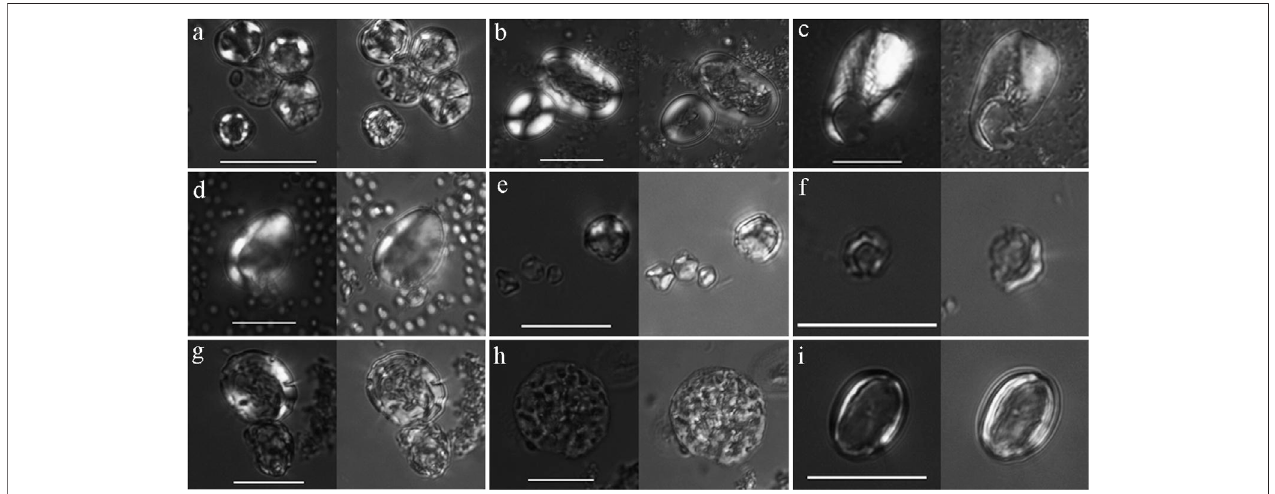
FIGURE 4 | Damaged starch grains in the three alcohol (scale bar: 20 μ m). (A) foxtail millet in koujiao alcohol; (B) mung bean in qu alcohol; (C) lotus root in qu alcohol; (D) yam in koujiao alcohol; (E,F) rice in malted alcohol; (G – I) wheat in malted alcohol.